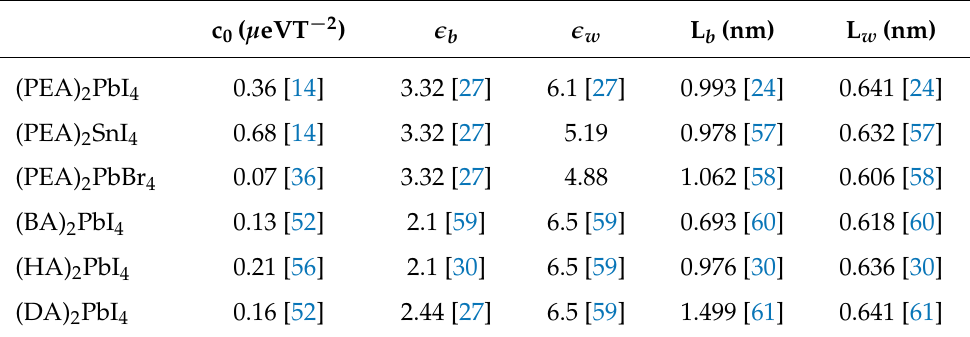
Table 1. Parameters of selected 2D layered perovskites. From the left: diamagnetic coefficient (c 0 ), high-frequency dielectric constant of organic ( (cid:101) b ) and inorganic ( (cid:101) w ) sublattices, as well as width of the organic (L b ) and inorganic (L w ) sublattices. (cid:101) w for (PEA) 2 SnI 4 and (PEA) 2 PbBr 4 was approximated with the procedure described in the main